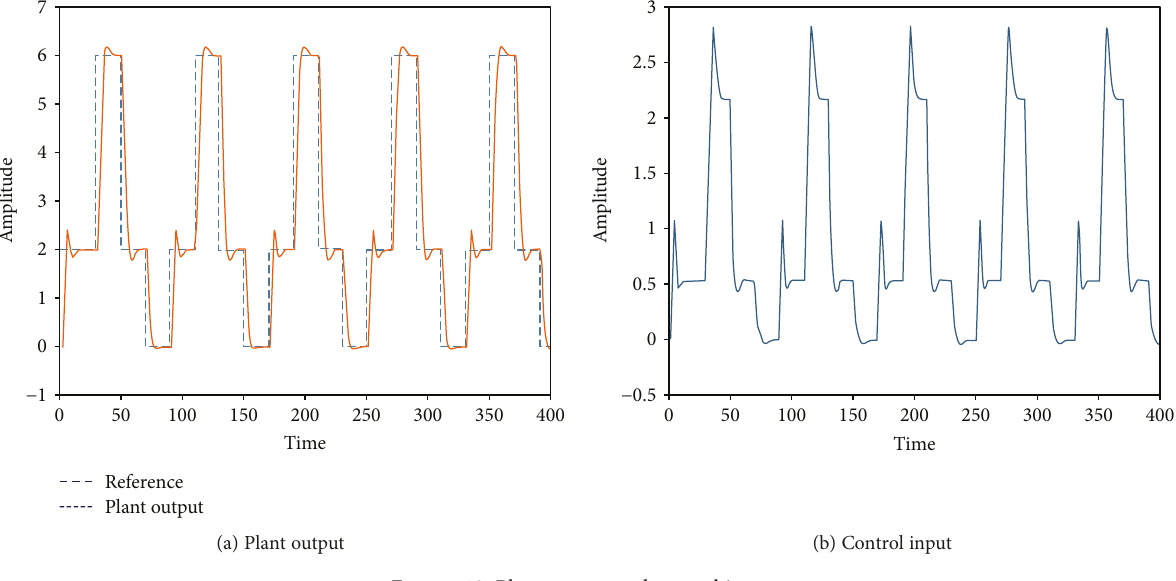
Figure 10: Plant output and control